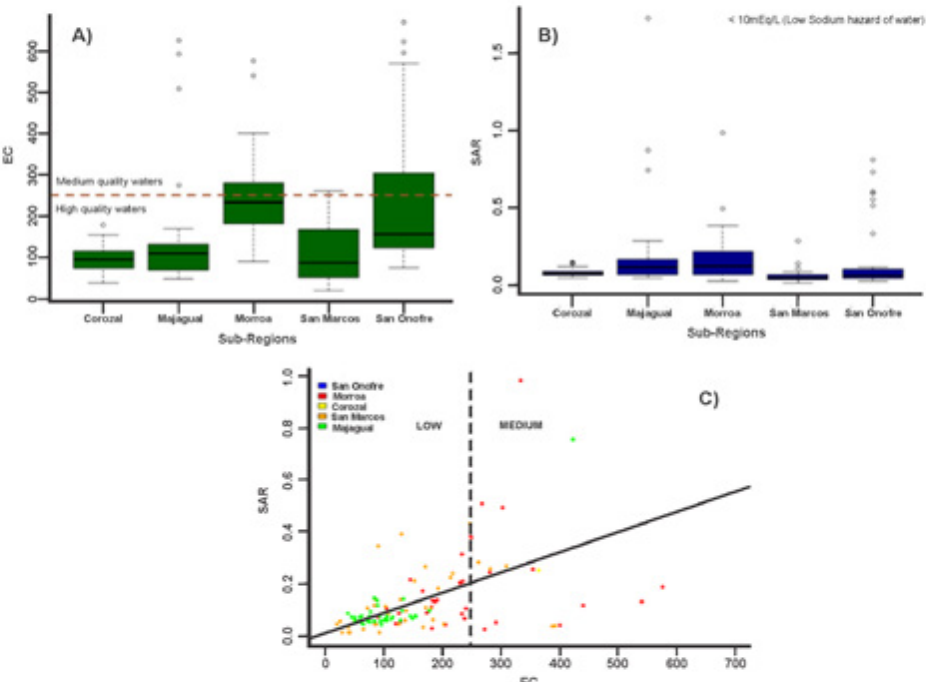
Fig. 2: A) Hazard level according to electrical conductivity. B) Sodization level. C) Sodium adsorption ratio (SAR) vs electrical conductivity (EC)